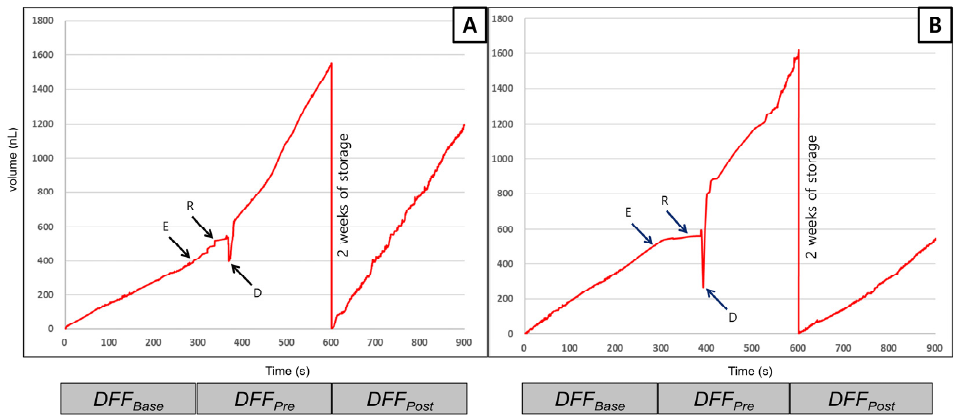
Figure 4. Representative graph of the real-time dentinal fluid flow (DFF) rate measurement. ( A ) The DFF rate of the SCA group. ( B ) The DFF rate of the BCA group. The gradient of each section means the DFF rate. The DFF rates of both groups decreased after being blot dried and increased more than that before acid etching. Abbreviations: E, etching with phosphoric acid; R, rinse; D, dry; DFF, dentinal fluid flow; SCA, silica-containing adhesive; BCA, BAG-containing adhesive